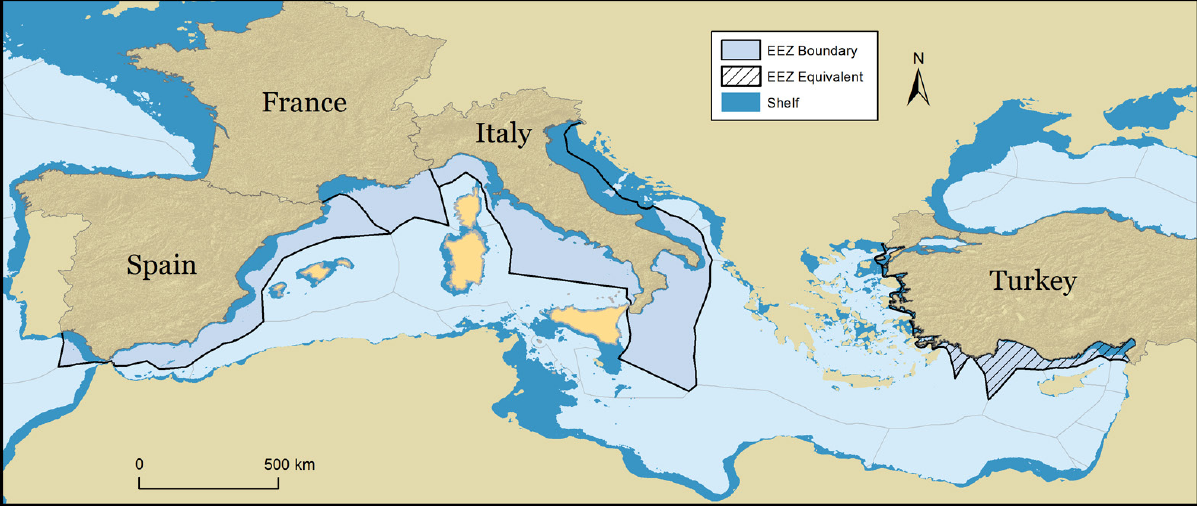
Fig. 1. – Location of the four exclusive economic zone (EEZ)-equivalent areas for which catches were reconstructed. Note that the Balearic Islands are not included with the Spanish Mediterranean coast (to which the Gulf of Cadiz area was appended, however), and nor are Corsica with France, Sardinia and Sicily with Italy, or the Dardanelles with Turkey. Based on non-official EEZ files distributed by the Flanders Marine Institute (VLIZ); see Suarez de Vivero (2010) for the current jurisdiction regarding EEZ claims in the